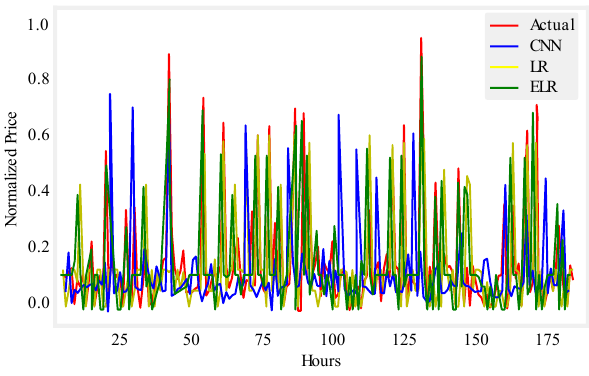
Figure 10. One month price prediction using